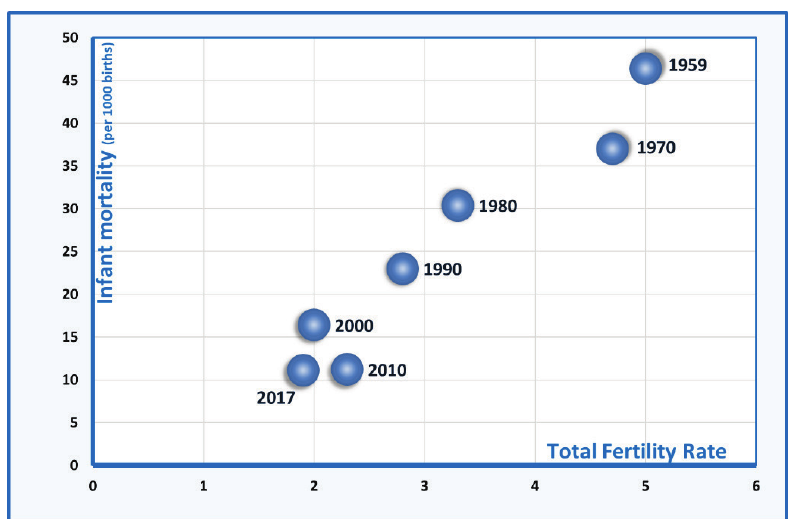
Figure 4. Historical evolution of the total fertility rate and infant mortality rate. Source: according to SSC